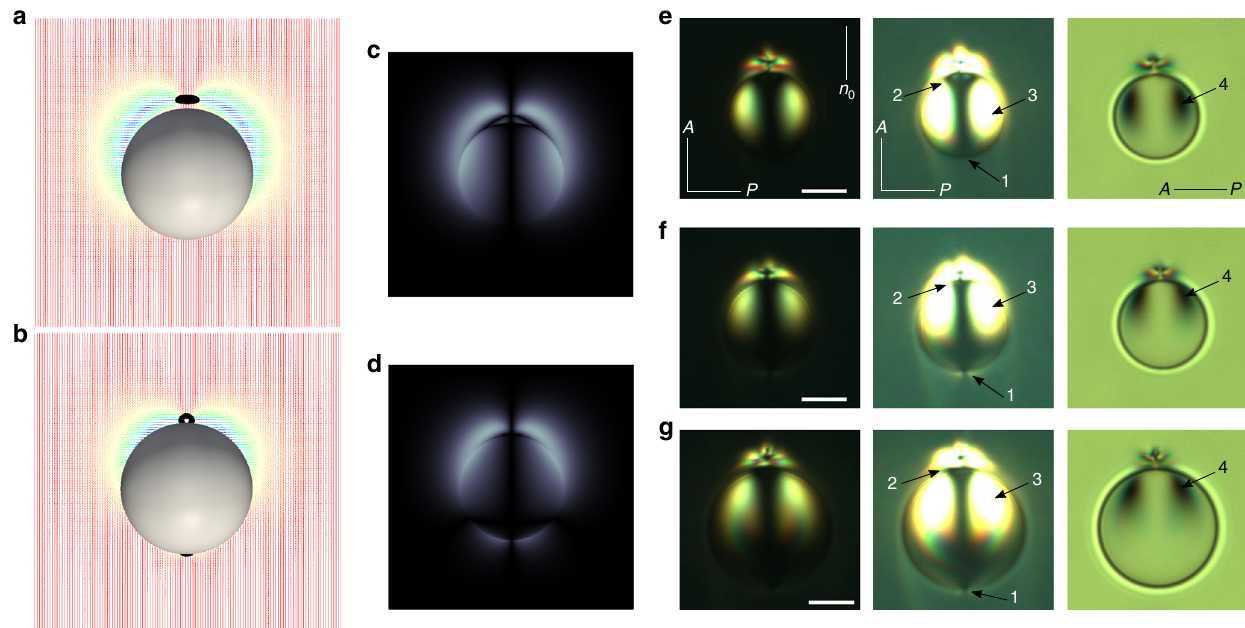
Fig. 3 Elastic dipoles. a , b Director fi elds for dipole colloids ( R = 750 nm) with θ e = 0° ( a ) and 45° ( b ), colored by its projection onto the z -axis. The defects are shown in black (isosurface for S = 0.6). c , d Corresponding simulated polarized light micrographs of dipole colloids with θ e = 0° ( c ) and 45° ( d ). e – g Optical microscopy textures of a dipole with homeotropic ( e ) and conic ( f , g ) anchoring, which are consistent with the predicted textures shown in ( a , c ) and ( b , d ), respectively; n 0 shows a far- fi eld director set by rubbing. Left and middle textures in e – g were taken between crossed polarizers A and P; textures in the middle are slightly overexposed to enhance visibility of boojums at the bottom pole. Textures in the right column were taken between parallel polarizers. Scale bar: 5 μ m ( e , f ) and 6 μ m ( g